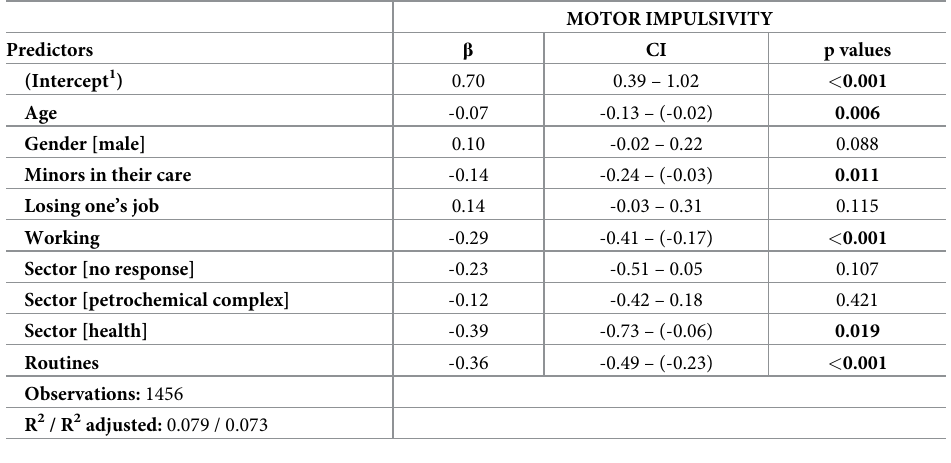
Table 9. Regression analysis relating to motor impulsivity in the